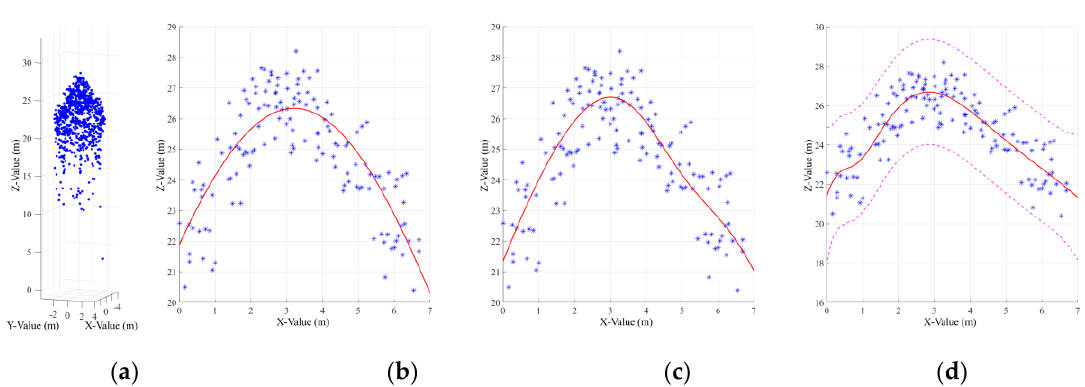
Figure 12. A tree segment with more than three crowns contained a multiple-tree centralized distribution. ( a ) Points in the segment. ( b – d ) Gaussian fitting of the profile selected from the segment that contained three canopies, where the number of functions increased from one to three. Blue points represent the upper canopy points, with the combined model represented with a red line. The magenta lines are the 99% confidence interval of three Gaussian function fitting models.